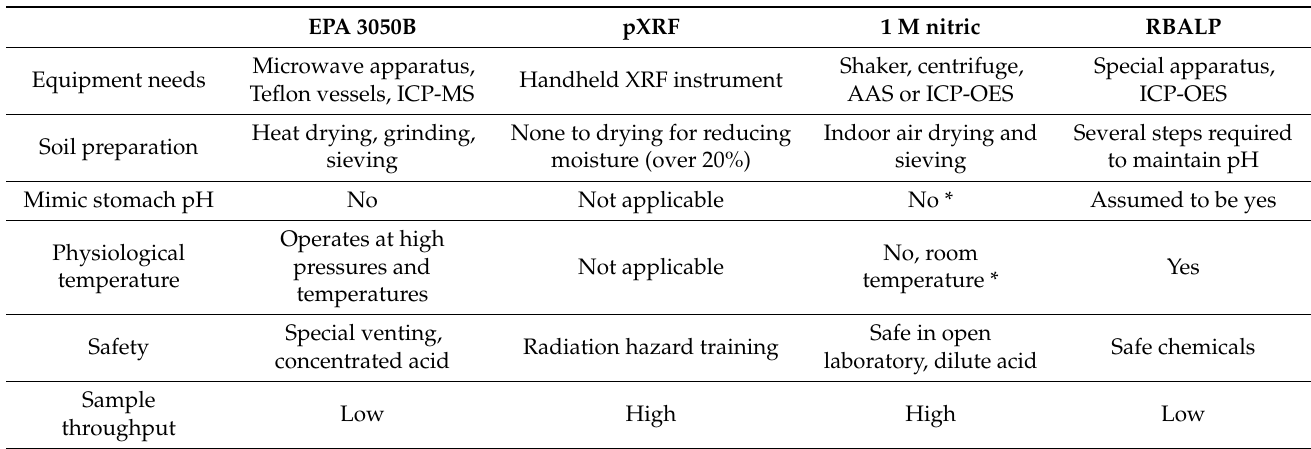
Table 2. Equipment needs, treatment of soil during preparation, stomach pH and temperature issues, safety, and productivity factors that should be considered when undertaking extensive urban soil survey monitoring